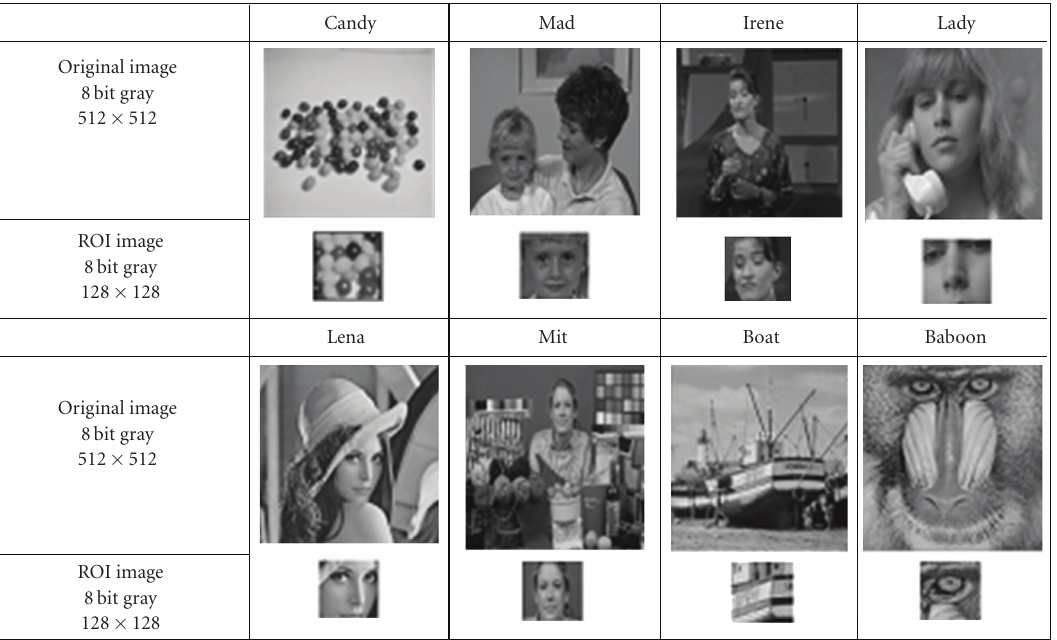
Figure 5: The original image and its selected ROI